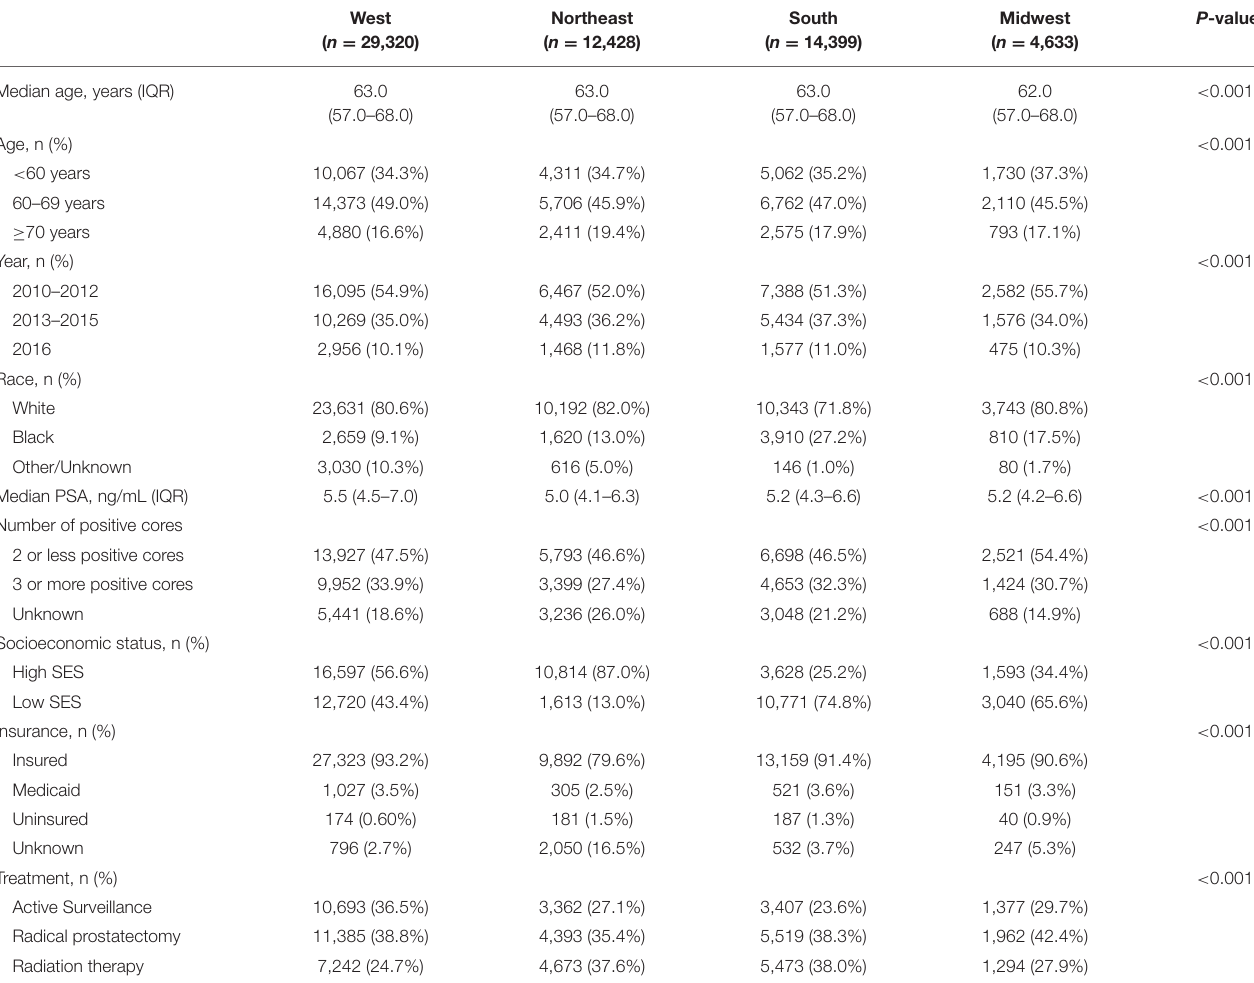
TABLE 1 | Characteristics of men with low-risk prostate cancer in each US census region between 2010 and